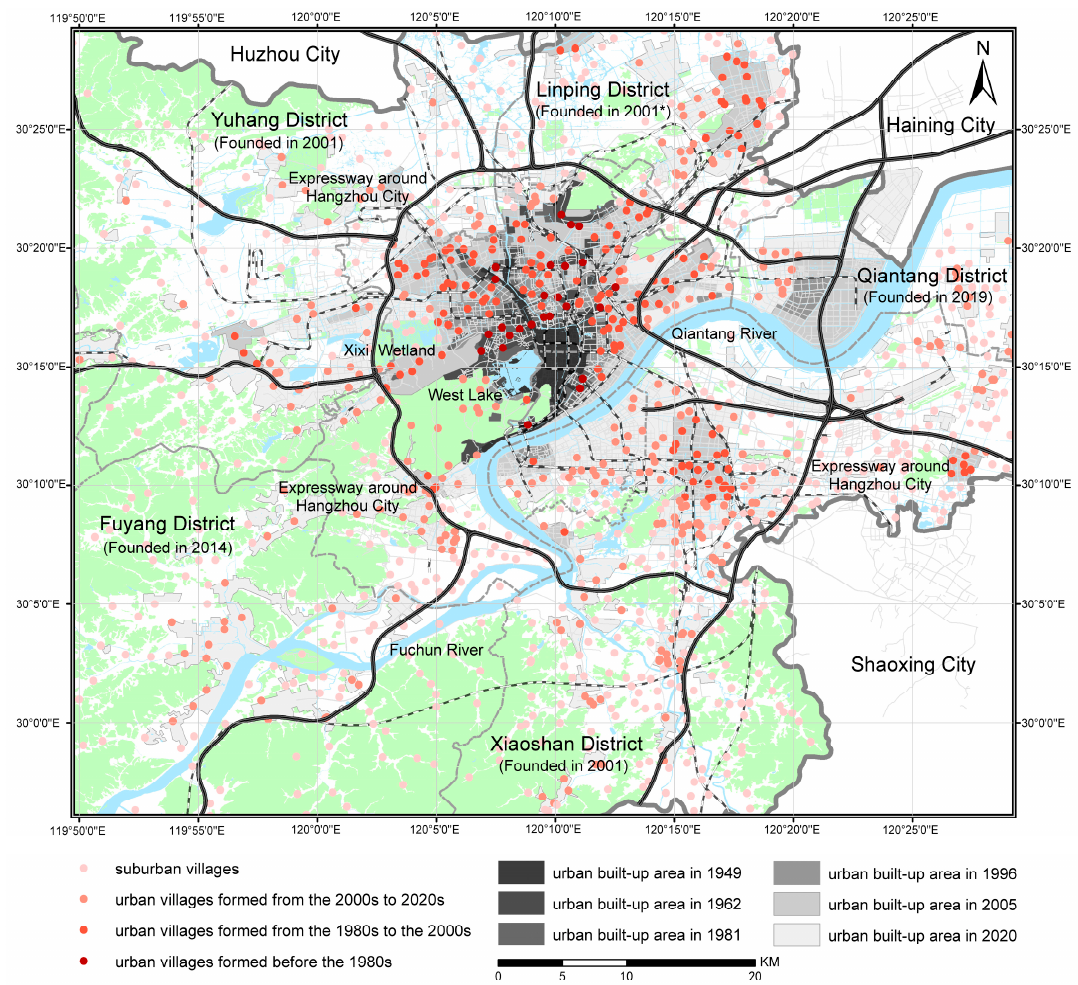
Figure 2. Spatial distribution of urban villages in Hangzhou urban district. * The territory of Linping